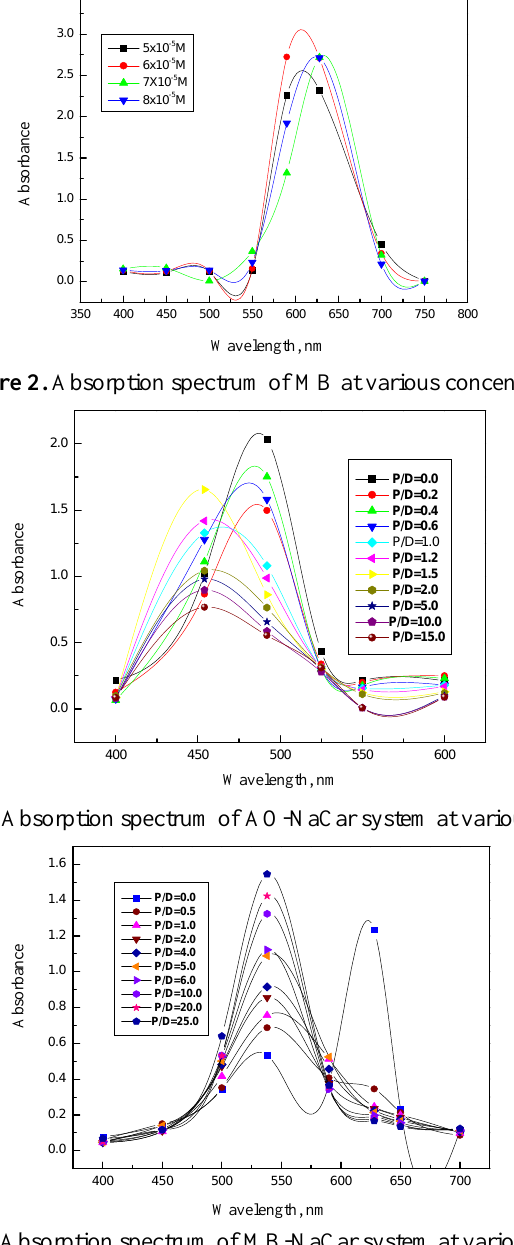
Figure 4. Absorption spectrum of MB-NaCar system at various P/D ratios Determination of